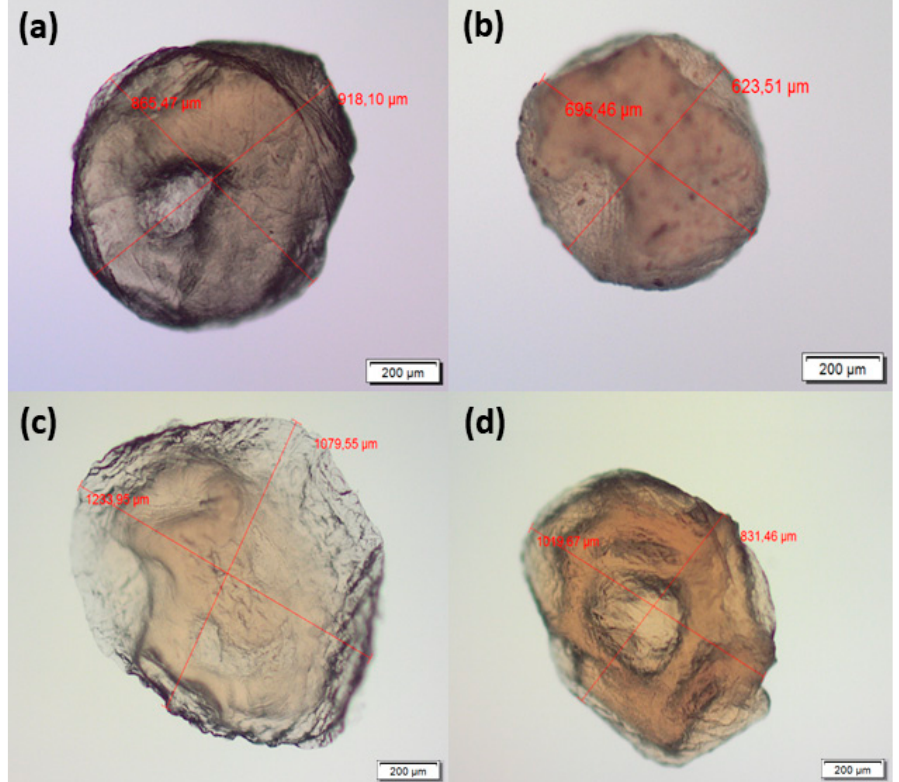
Figure 1. Images of dry microparticles obtained under an optical microscope (Leica MZ16a stereomicroscope, Leica Microsystems Ltd., Switzerland): ( a ) Alg ( b ) Alg/Z ( c ) Alg/HPMC, and ( d ) Alg/Z/HPMC. Bars are indicated.